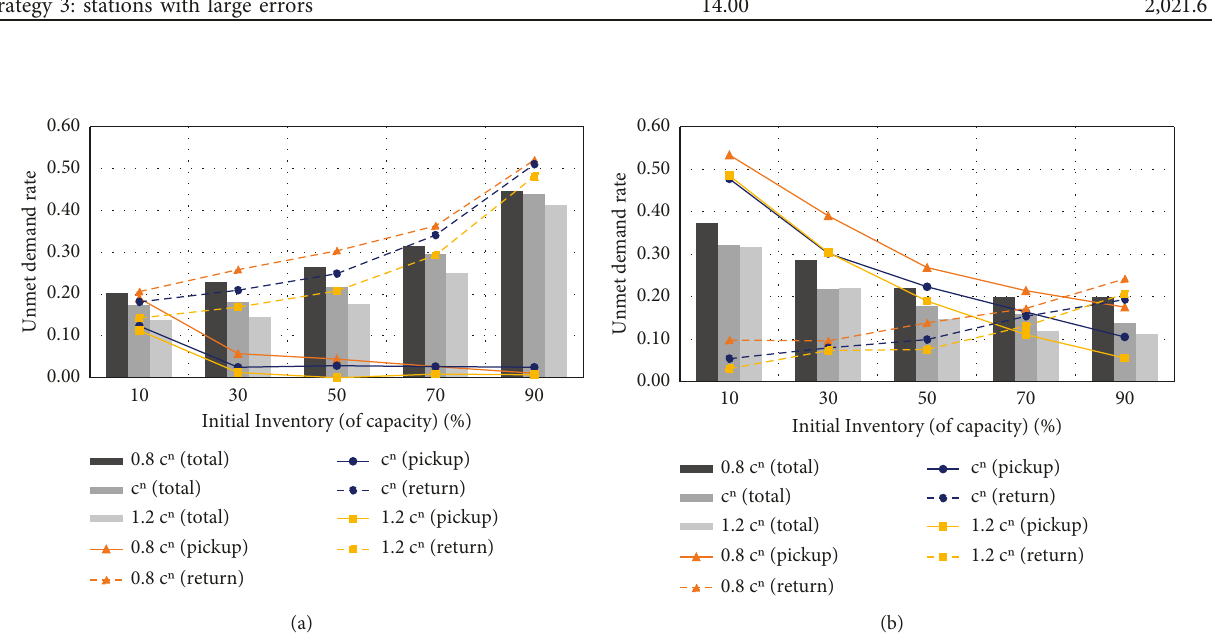
Figure 5: Sensitivity analysis with initial inventory and station capacity. (a) Morning peak; (b) evening peak.